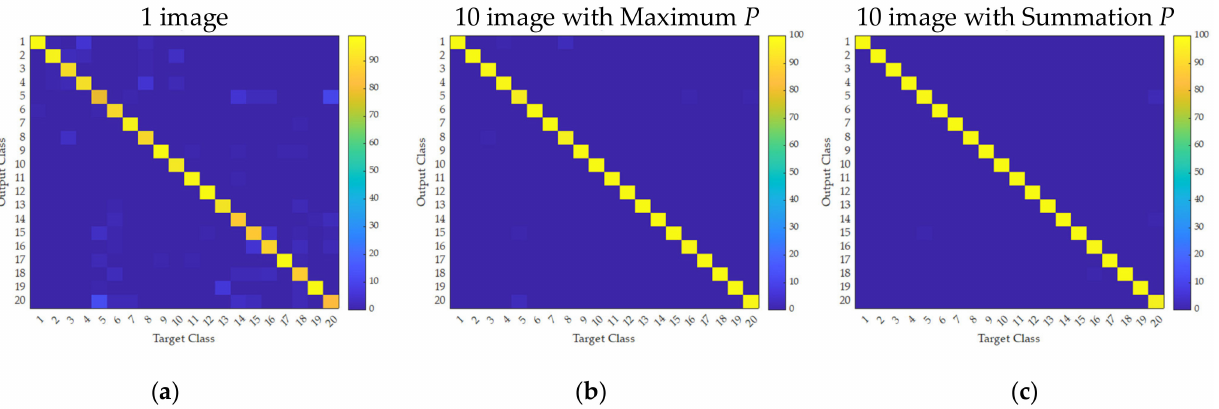
Figure 27. Confusion matrices obtained from multiple handling of the object using a DCNN: ( a ) once; ( b ) 10 times based on the maximum of probability; ( c ) 10 times based on the summation of